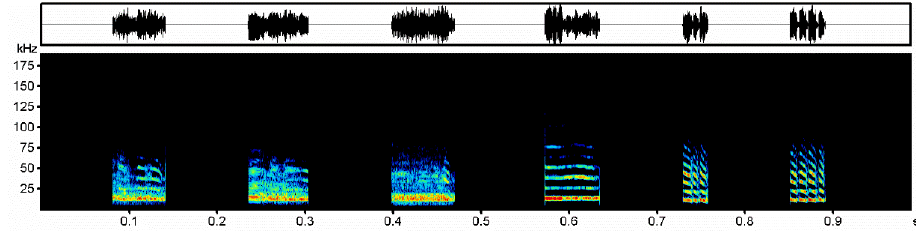
Figure 1. Aggressive calls of Vespertilio sinensis ; the three on the left are noisy syllable (noisy calls), and the three on the right are tonal syllable (tonal calls).